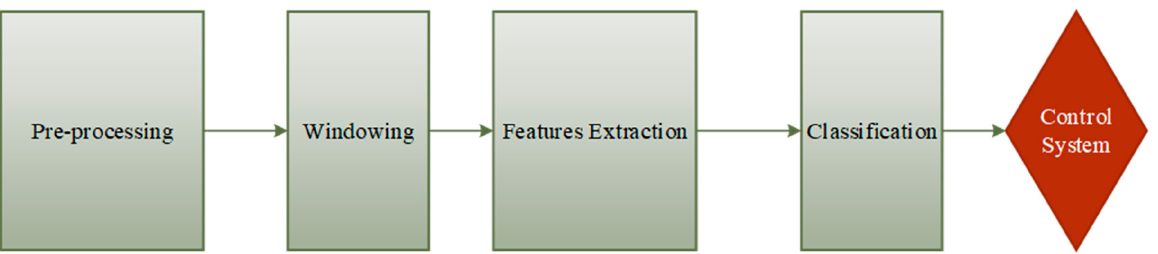
Figure 5. EEG signal processing for HMI.